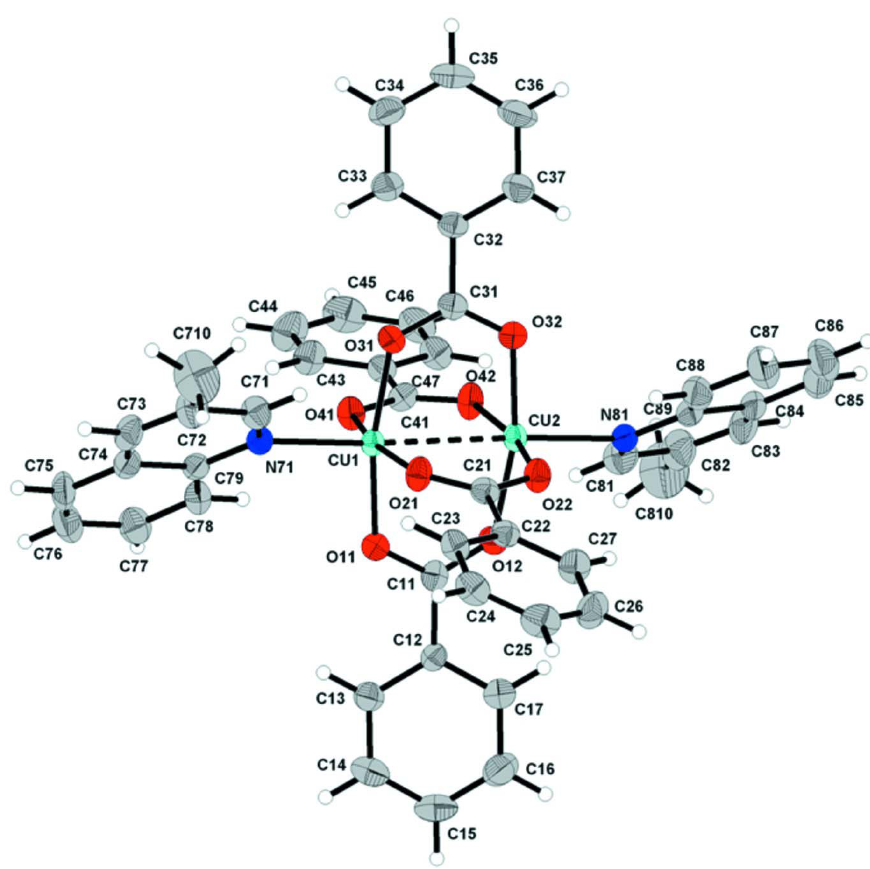
The molecular structure of one independent molecule of the title compound showing the atom-labeling scheme. Displacement ellipsoids are shown at the 30% probability